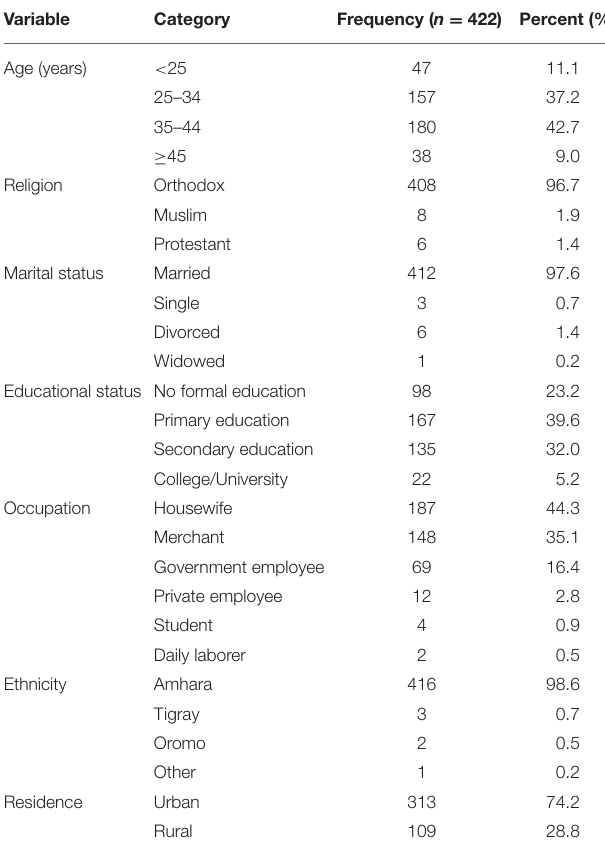
TABLE 1 | Sociodemographic characteristics of pregnant women attending the MCH clinic of DTCSH in Debre Tabor, Northwest Ethiopia, 2022.